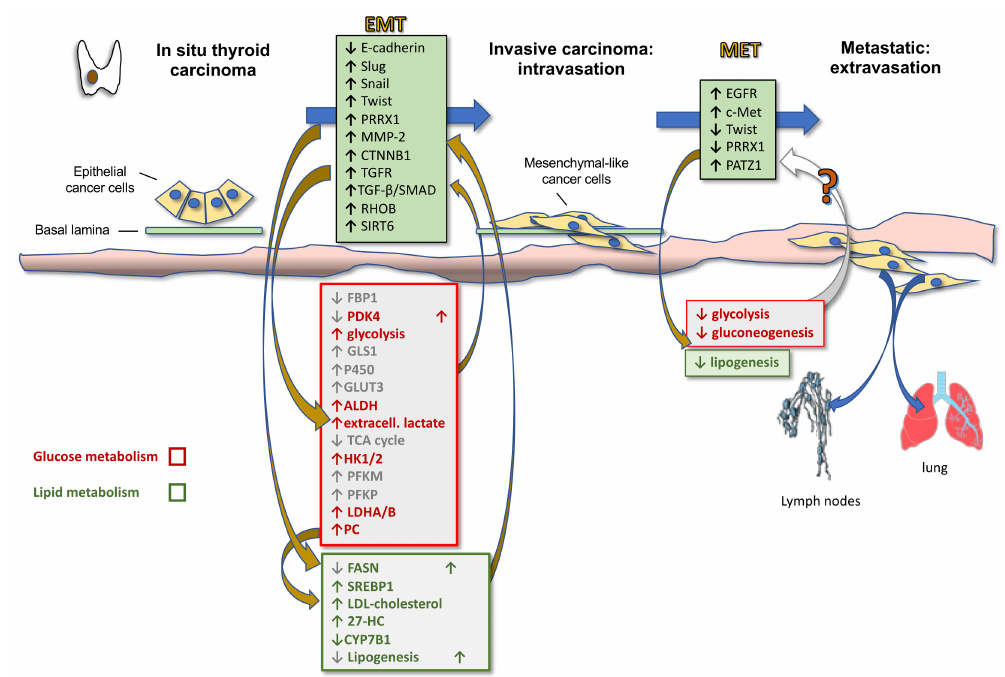
Figure 2. Thyroid cancer progression: reciprocal role of EMT and metabolic reprogramming. The cartoon illustrates the phases of thyroid cancer progression, from in situ to invasive carcinoma and metastatic tumor, highlighting the molecular actors of EMT as well as their reciprocal relationship with metabolic players. Upregulation (arrow up)/downregulation (arrow down) of proteins demonstrated in other cancers but not yet validated in TC is shown in